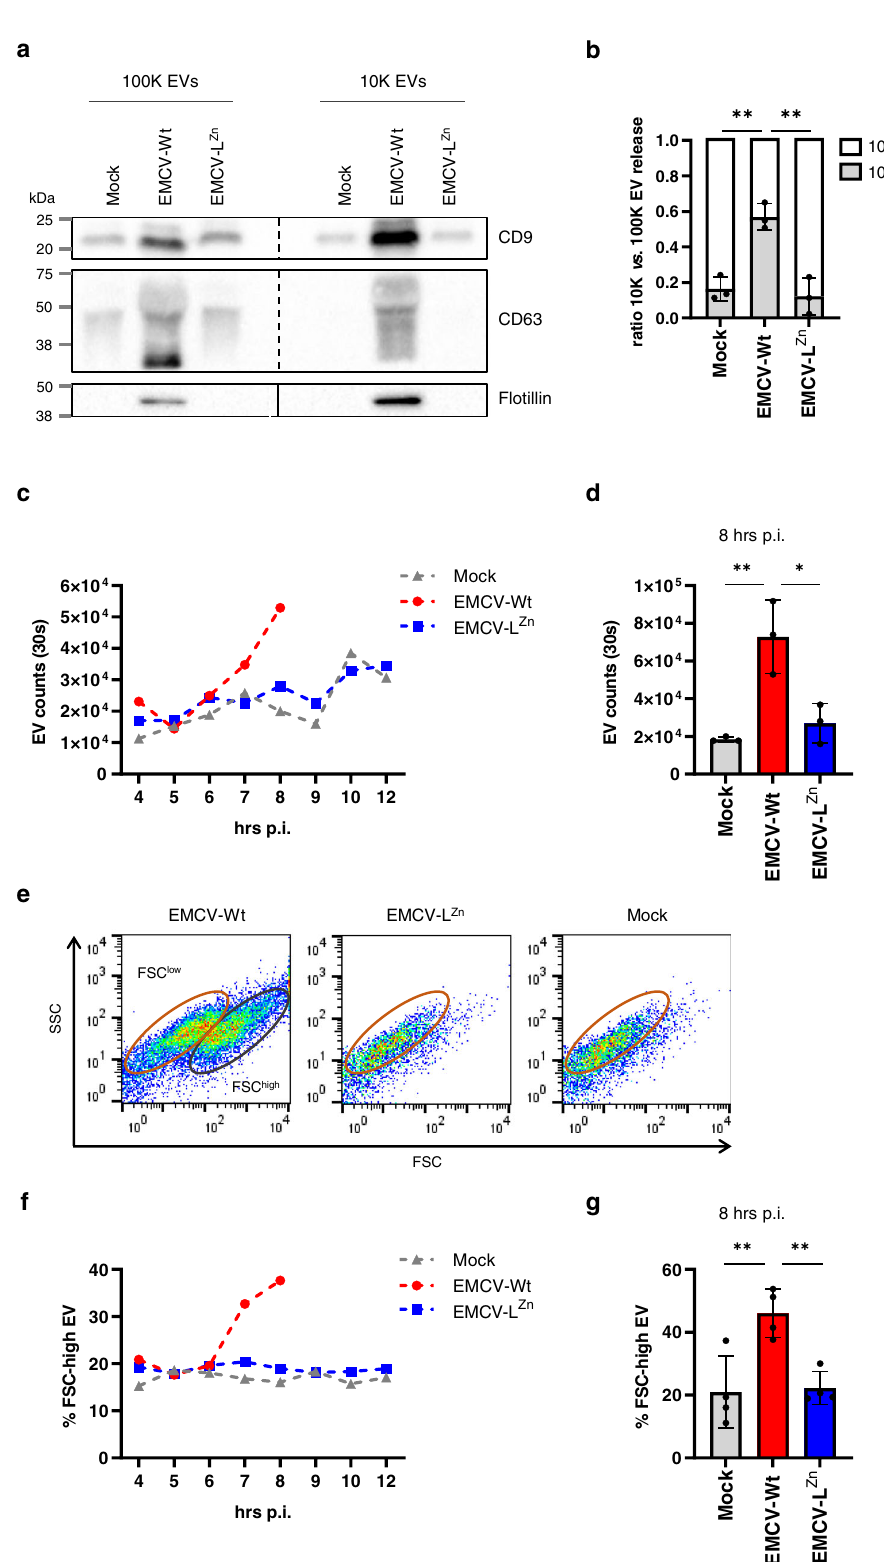
The EV proteome suggests a potential role for secretory autophagy in Leader-induced EV release . To further investigate how the Leader protein affects the composition and release of EVs and EV-enclosed virus, we compared the host protein composi- tion of EV preparations ( n = 3 replicates) from cells infected with EMCV-Wt or EMCV-L Zn . Proteins involved in EV formation